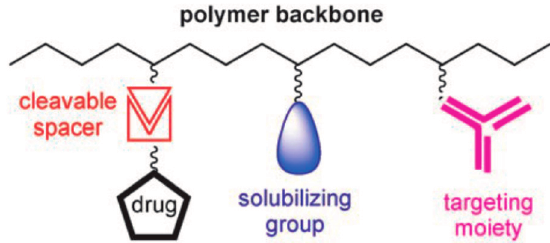
Figure 7. Ringsdorf’s model for drug-delivery systems based on synthetic polymers. Reprinted with permission from [79], Copyright © 2006 WILEY-VCH Verlag GmbH & Co. KGaA,